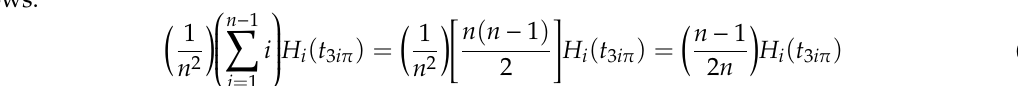
Figure 4. Inventory status in t 3 i π at the manufacturer side.